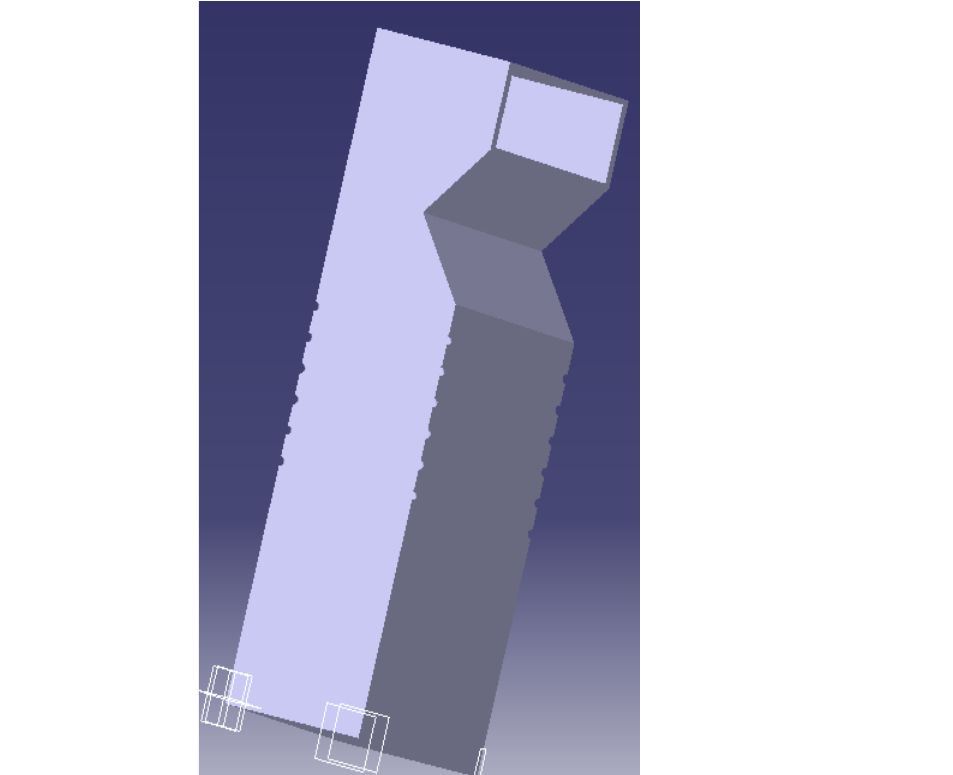
Figure 5. Supercritical Boiler front geometry.